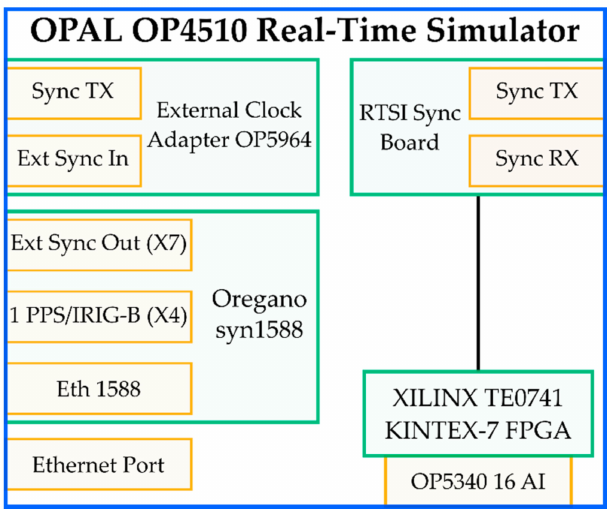
Figure 7. Main components of the OPAL OP4510